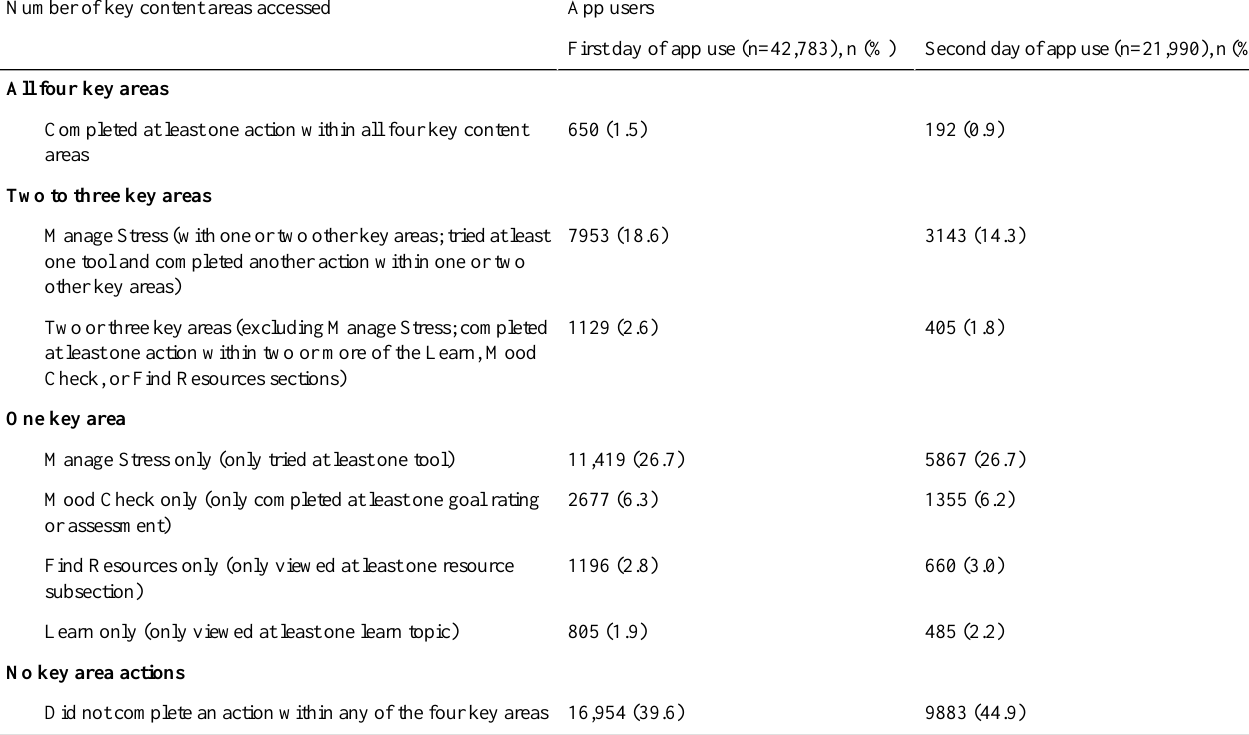
App usersNumber of key content areas